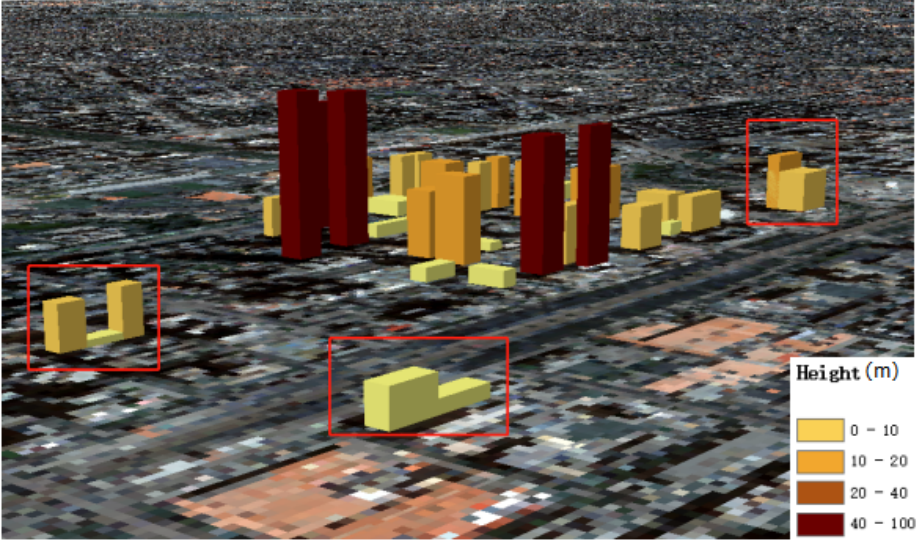
Figure 22. The 3D reconstruction models of the proposed solution in Xi’an. The red box indicates the podium